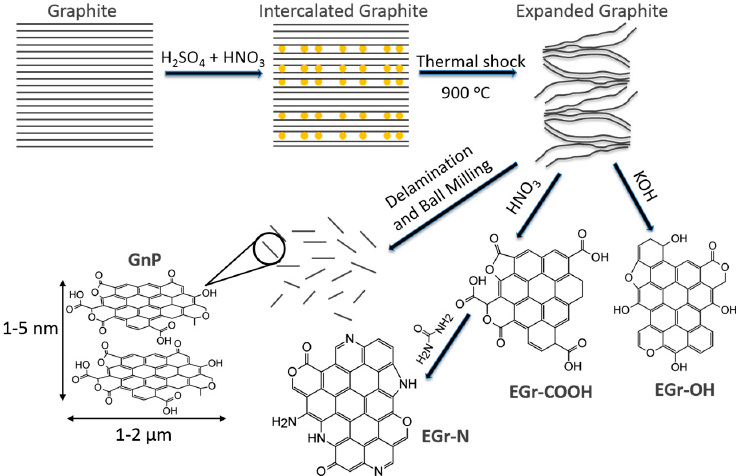
Figure 1. Schematic showing the processing steps from natural graphite to the expanded graphite (EGr), surface modifications: carboxylated (EGr-COOH), hydroxylated (EGr-OH) and aminated (EGr-N) and graphene nanoplatelets (GnP).